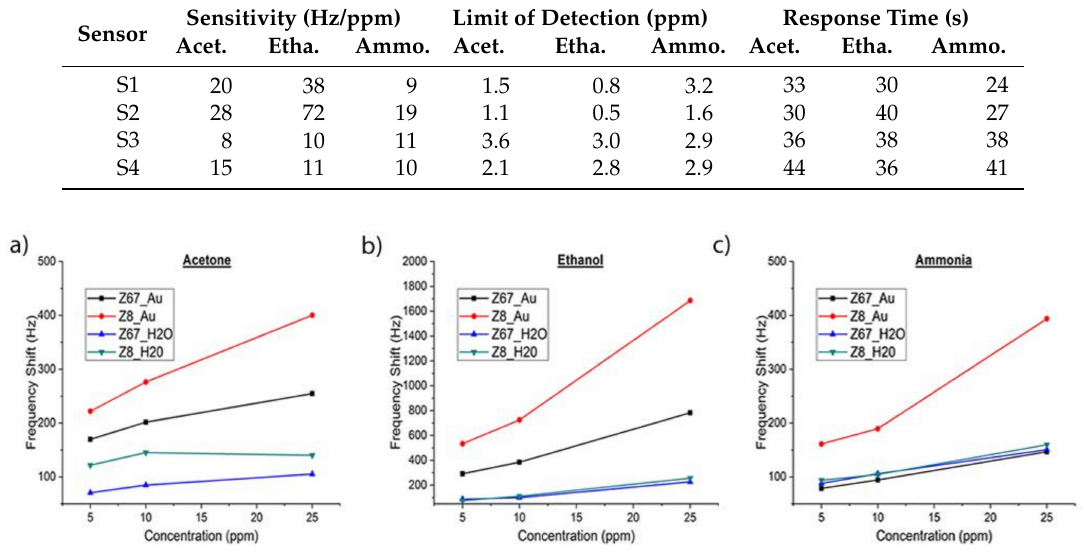
Table 3. Sensitivity, limit of detection and response time of the sensors S1, S2, S3 and S4 obtained from responses of 10 ppm.